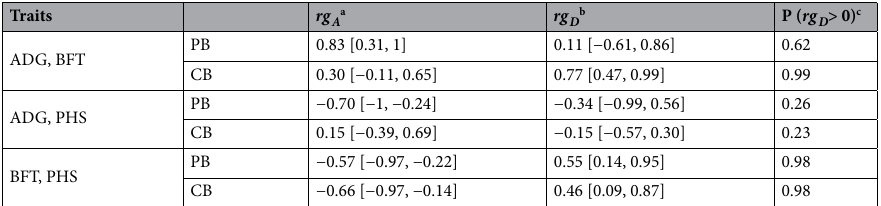
Table 4. Mean [highest posterior density interval at 95%] of the estimated marginal distribution of the additive and dominance genotypic correlations between traits estimated in a purebred (PB) and a crossbred (CB) population. ADG average daily gain, BFT backfat thickness, PHS pH of the semimembranosus muscle. ) . c Probability of a positive a Additive genotypic correlation ( rg b Dominance genotypic correlation ( rg A ). D dominance genotypic correlation (P ( rg D >